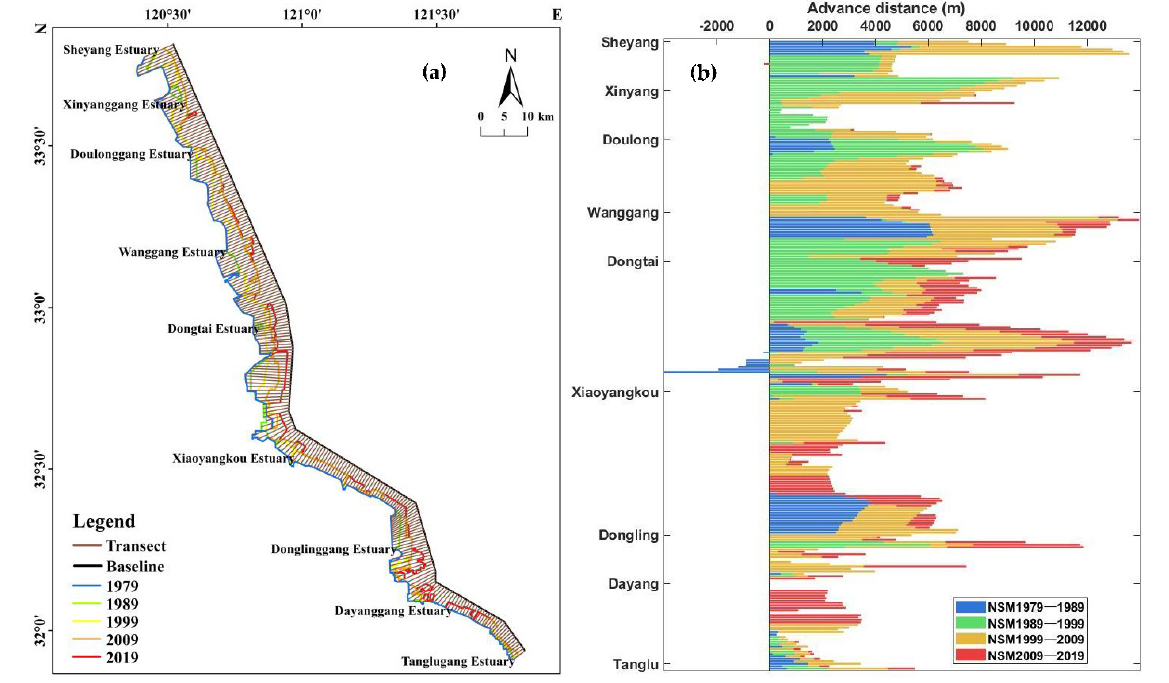
Figure 6. ( a ) Shorelines, baselines, and transects of the RSRs; ( b ) net shoreline movemen t (NSM) of shoreline in different periods of the RSRs from 1979 to 2019. shoreline in different periods of the RSRs from 1979 to 2019.